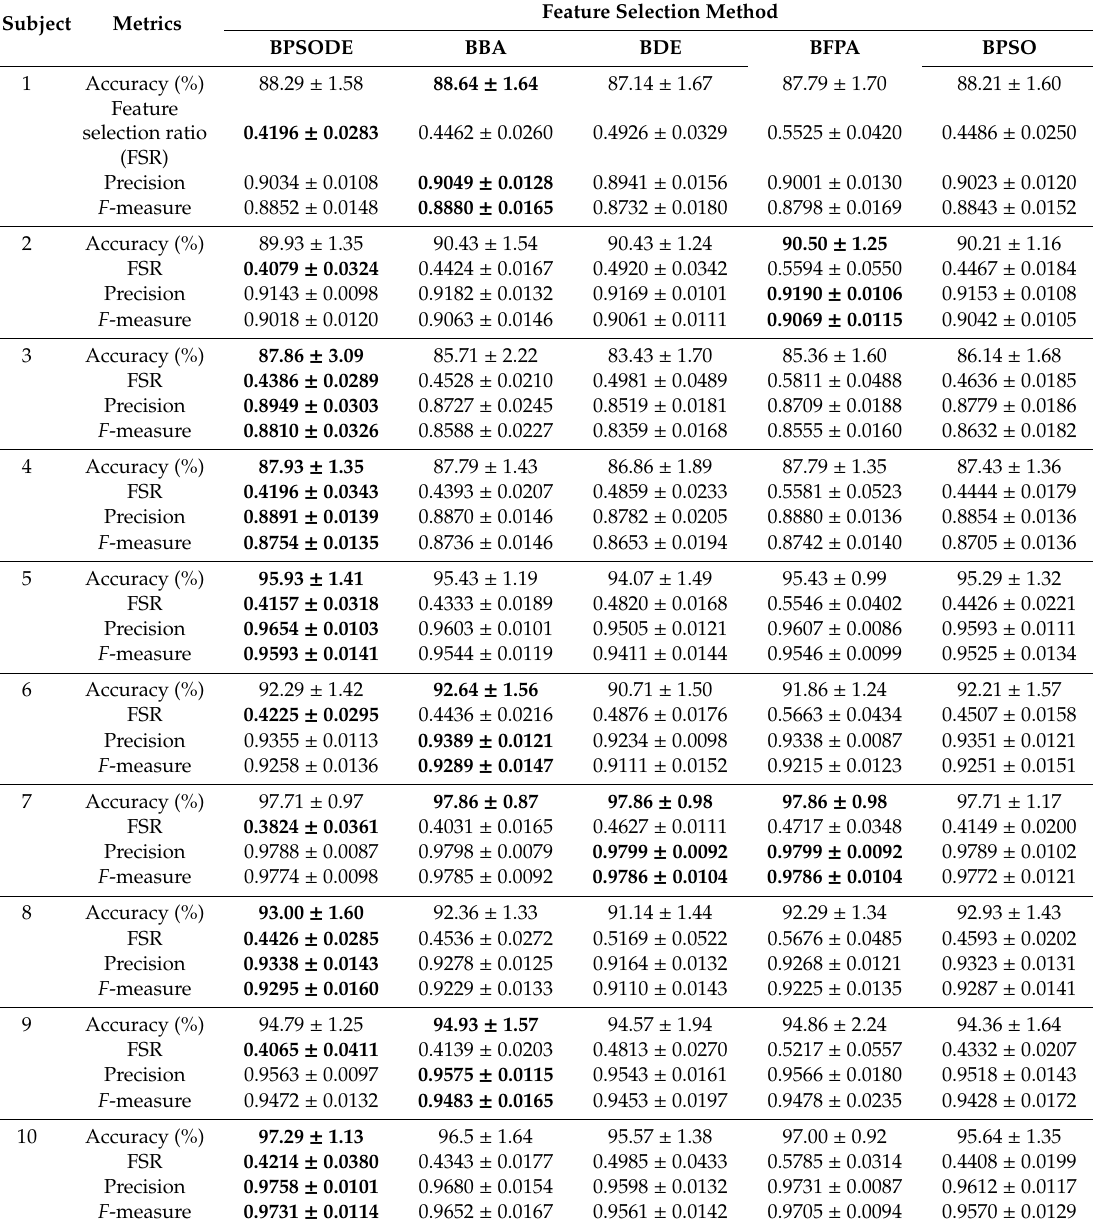
Table 2. Experimental results of five di ff erent feature selection methods on 10 subjects. The best result of each metric is highlighted in bold